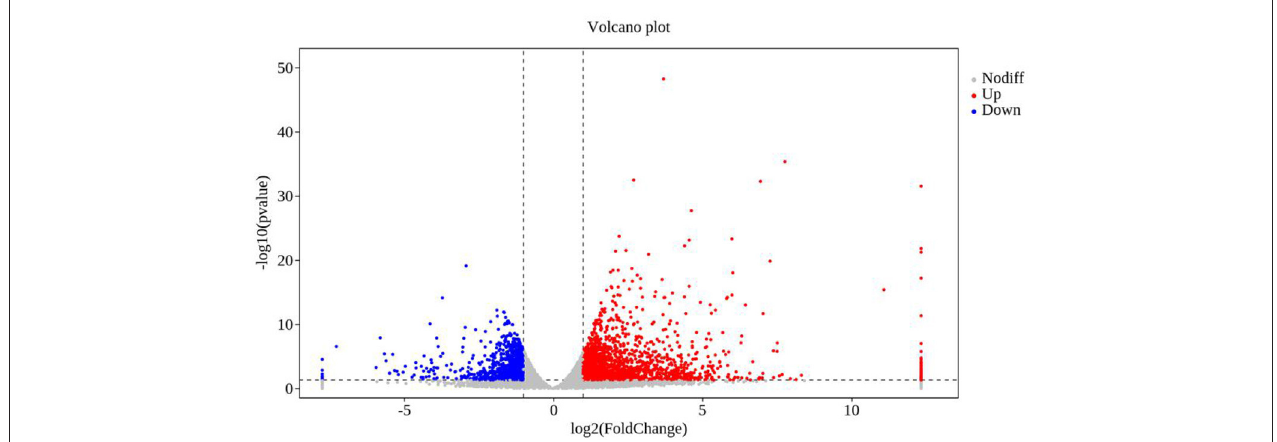
FIGURE 2 | Volcanic diagrams of differential expression genes. The horizontal coordinates are log2 (fold change) and the ordinates are -log10 ( p -value). The two vertical dashed lines are 2 times the difference threshold, and the horizontal dashed lines are p -value 0.05 thresholds. A red dot indicates the upregulated genes group, a blue dot indicates the downregulated genes group, and a gray dot represents a non-significant difference in the expression of the genes group. The scale was fixed considering the minimum and maximum log2 values (between − 7.74 and 12.33) included in the Supplementary Tables 1, 2